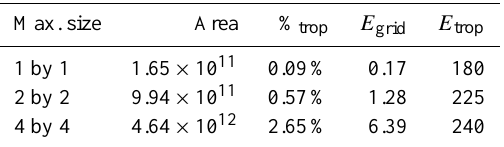
Fig. 4. Each black square represents an individual grid cell in the dilution matrix presented in Fig. 2 and, assuming a uniform emission throughout that area, shows the cumulative percentage of a simulated concentration at both measurement sites that is accounted for by adding emissions from that grid cell. The grid cells are counted successively, beginning with the grid cell containing the highest dilution value and finishing with the grid cell containing the lowest. This accumulated percentage is plotted against the surface area covered by the increasing number of grid cells considered. The lines relate to the different sized grid cells in the inversion solution grid. The red line (and label) shows that 44% of the hypothetical modelled concentration is caused by emissions in grid cells of size 1 by 1, which cover an area of ∼ 1.6 × 10 11 m 2 . The orange (2 by 2), blue (4 by 4) and grey (8 by 8 to 32 by 32) lines indicate this relationship when solution grid cells of increasing size are also included in the calculation. For reference, the surface area between 20 ◦ S–20 ◦ N is 1.75 × 10 14 m 2 . Table 1. The area (in m 2 ) occupied when different maximum solu- tion grid cell sizes (see also Figs. 3 and 4) are considered, and the percentage of the tropics (20 ◦ S–20 ◦ N) this area covers. Then, for experiment D, the total emission from the selected grid ( E grid ), and that emission extrapolated across the tropics ( E trop ). Emission units are GgCHBr 3 yr − 1